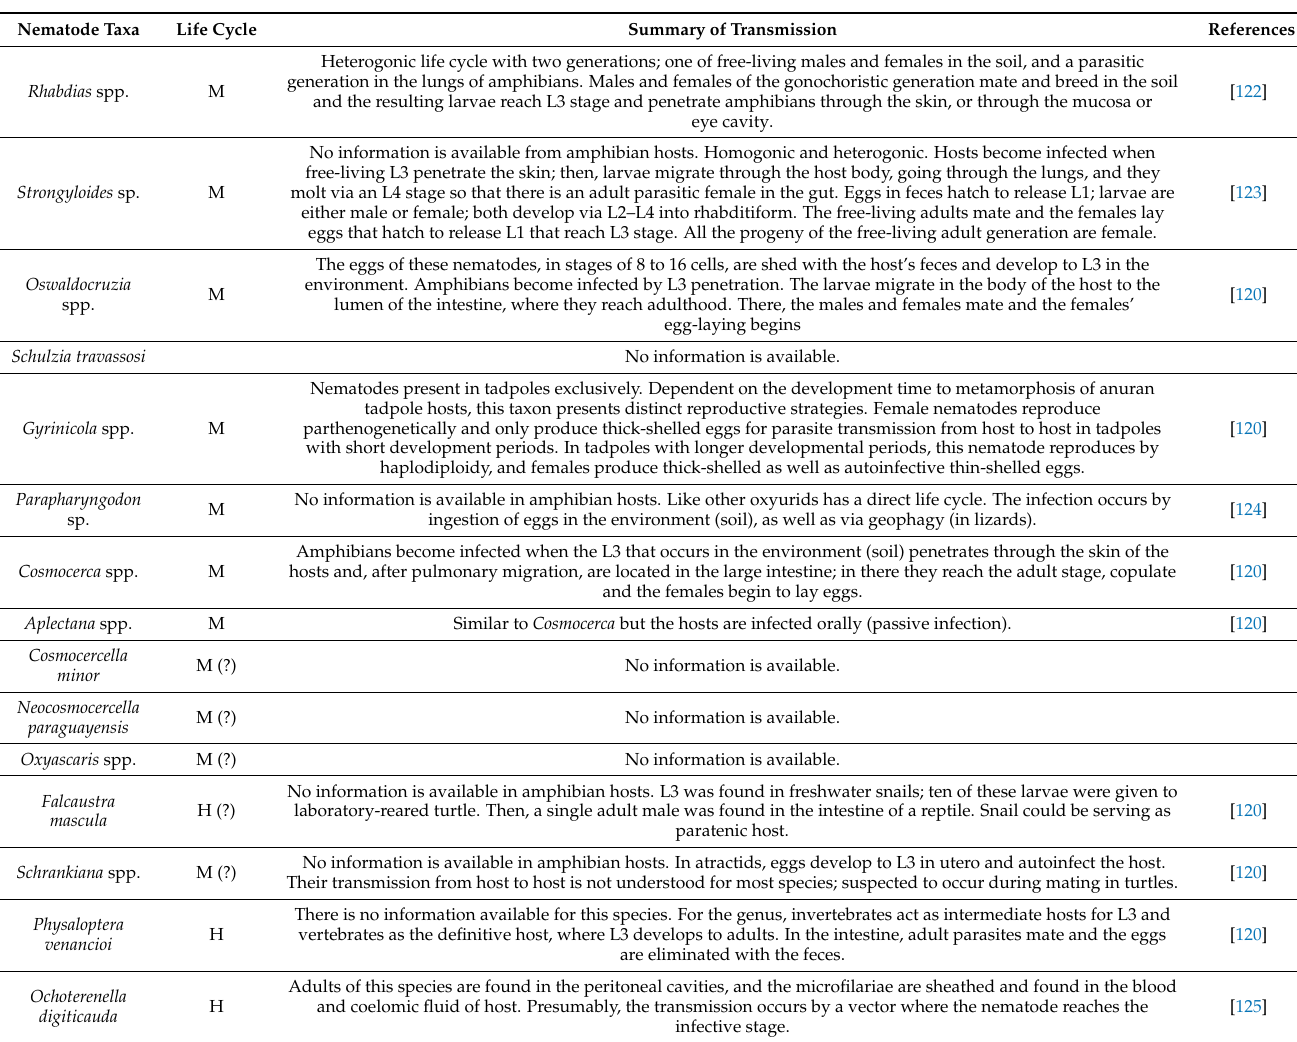
Table 1. Summary of nematode taxa in adult stage found in amphibian hosts from Dry and Humid Chaco ecoregions. Life cycle: M: monoxenous, H: